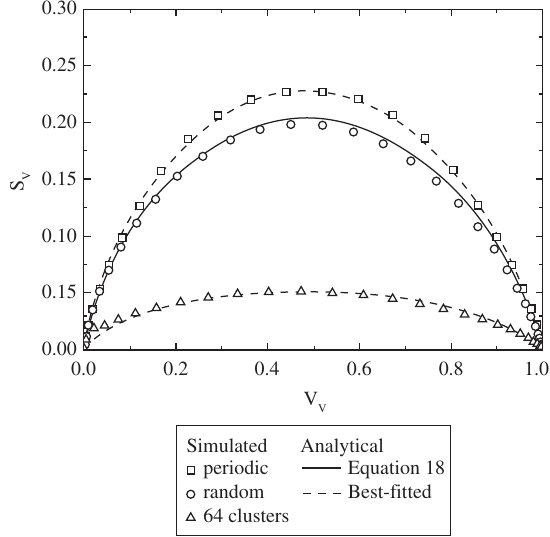
Figure 7. Interfacial area between recrystallized grains and matrix, S volume fraction, simulated by CA. Simulation data are force fitted by Equa- tion 18, allowing N to V